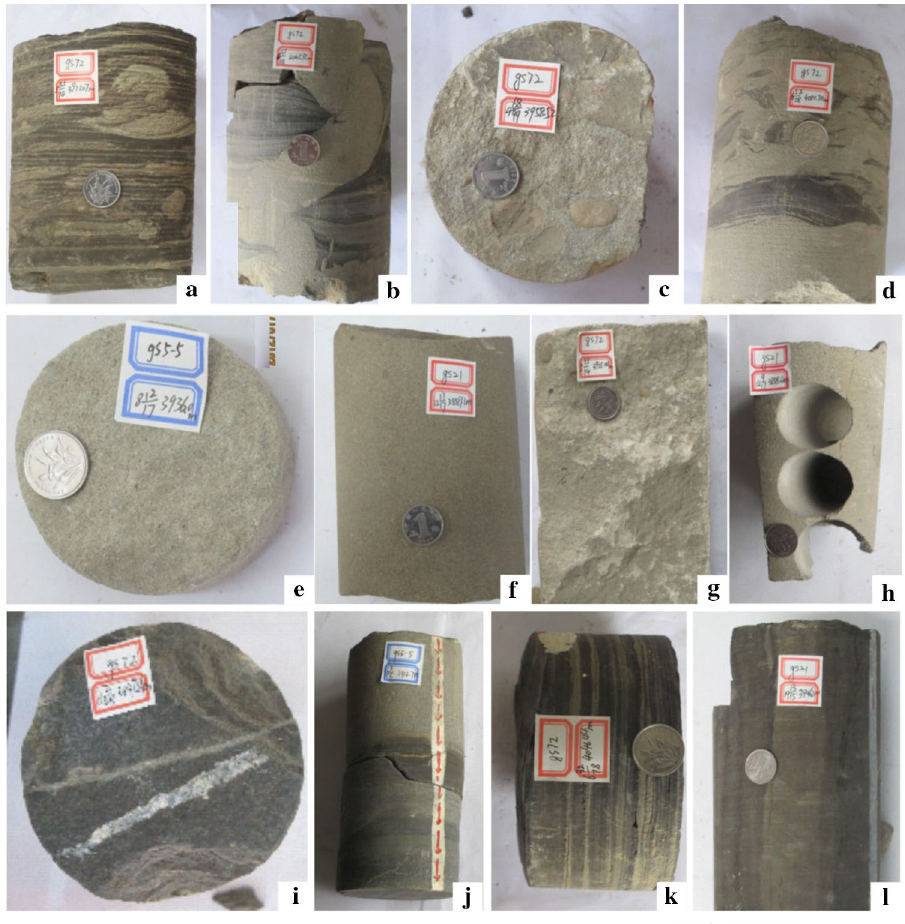
Fig. 2 Core photographs representative of low perme- ability reservoirs in Maxi Oilfield. a Orbicular structure at 3971.1 m in well gs72. b Banded sandbody embedded in mudstone at 4047.9 m in well gs72. c Mud gravels of varying sizes in sandstone at 3958.5 m in well gs72. d Mudstone debris at 4050.7 min well gs72. e Massive bedding with fine sand- stone at 3936.0 m in well gs5-5. f Massive bedding with siltstone at 3887.1 m in well gs21. g Massive bedding with higher mud content at 3887.1 m in well gs72. h Massive bedding with fractures at 3885.4 m in well gs21. i Fractures with calcite at 3937.8 m in well gs72. j Abrupt interface of gravity flow channel at 3912.7 m in well g5-5. k Parallel lamination at 4046.4 m in well gs72. l Dark gray and gray black mud at 3906.2 m in well